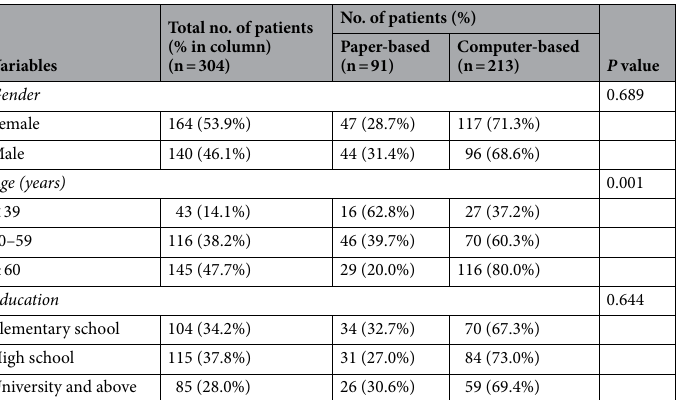
Table 1. Demographic characteristics of patients who underwent shared decision-making (SDM) based on paper-based or computer-based methods. SDM shared decision-making.